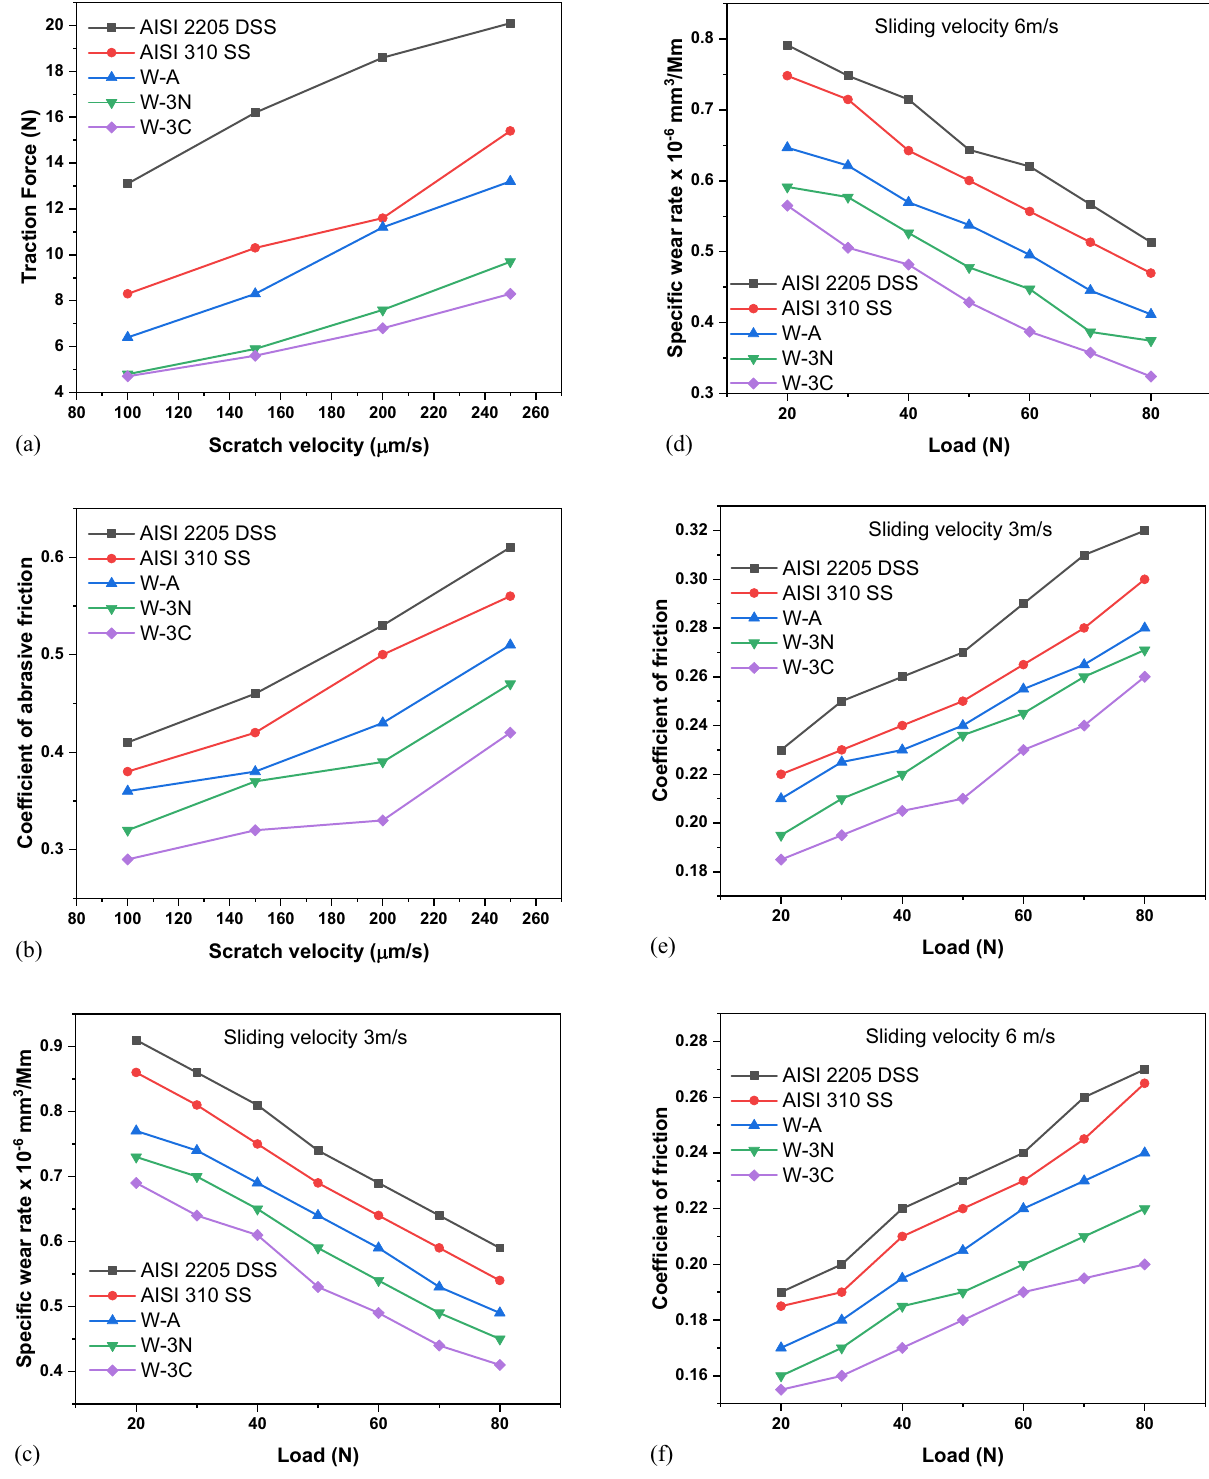
Figure 13: Variations in ( a ) traction force, ( b ) coe ffi cient of abrasive friction, ( c ) speci fi c wear rate ( sliding velocity 3 m · s − 1 ) , ( d ) speci fi c wear rate ( sliding velocity 6 m · s − 1 ) , ( e ) coe ffi cient of friction ( sliding velocity 3 m · s − 1 ) , ( f ) coe ffi cient of friction ( sliding velocity 6 m · s − 1 ) , ( g ) wear mass loss ( sliding velocity 3 m · s − 1 ) , and ( h ) wear mass loss ( sliding velocity 6 m · s − 1 )